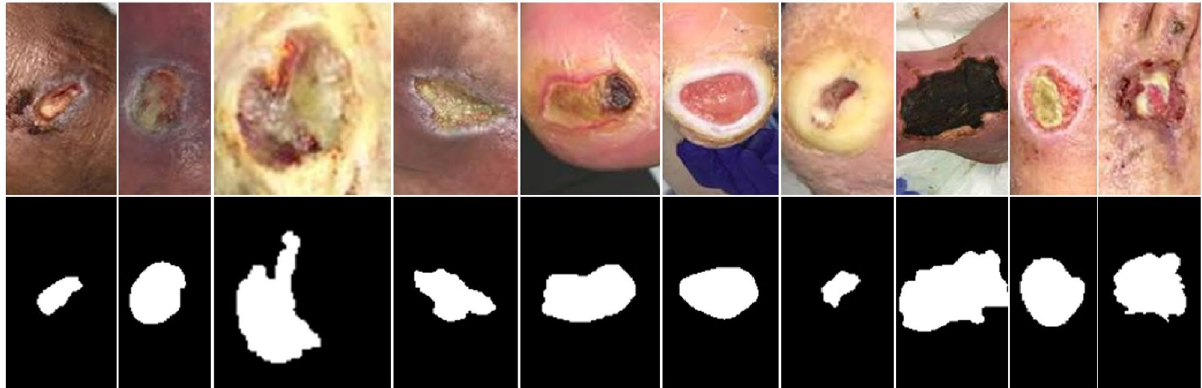
Figure 1. An illustration of images in our dataset. The first row contains the raw images collected. The second row consists of segmentation mask annotations we create with the AZH wound and vascular